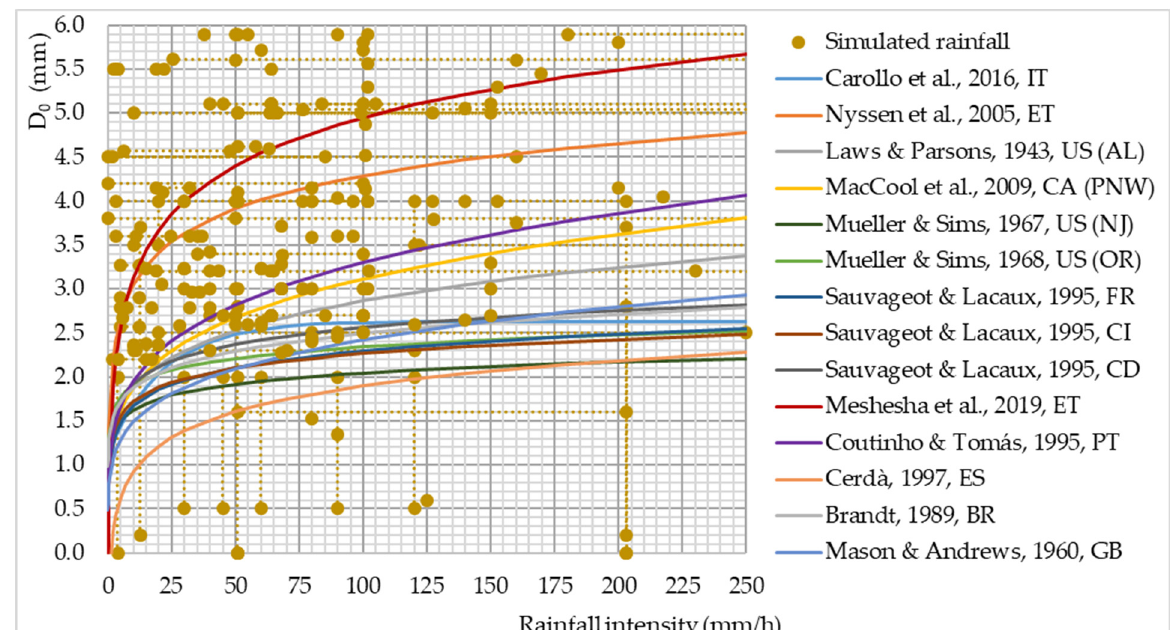
Figure 9. D 0 as a function of intensity for natural and simulated rainfalls. Note: two capital letters after reference represent the ISO Alpha-2 country code that designates countries in which measurements have been conducted [21,54,99–102,113,124–128]. Note: dotted lines represent simulated D 0 and rainfall intensity values that are given in a range.